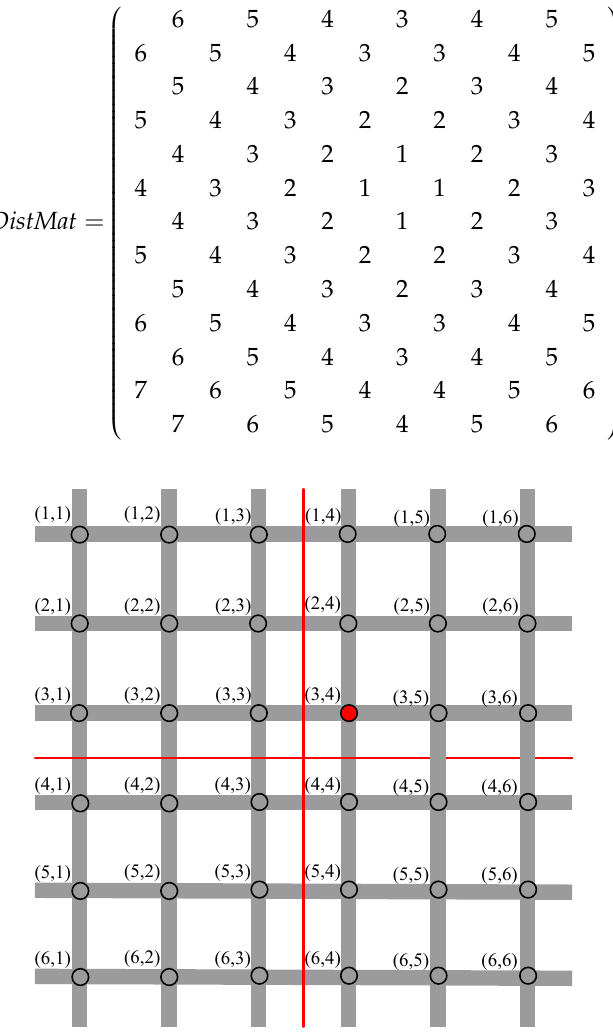
Figure 9. Road network with six vertical roads intersected with six horizontal roads.